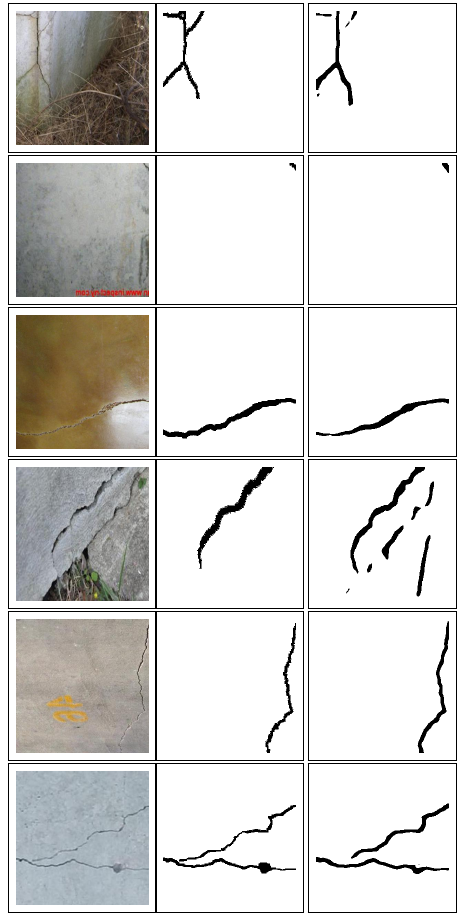
Figure 4. Sample RGB images from validation set ( left column) with corresponding ground truths ( middle column) and predicted binary image of the crack ( right